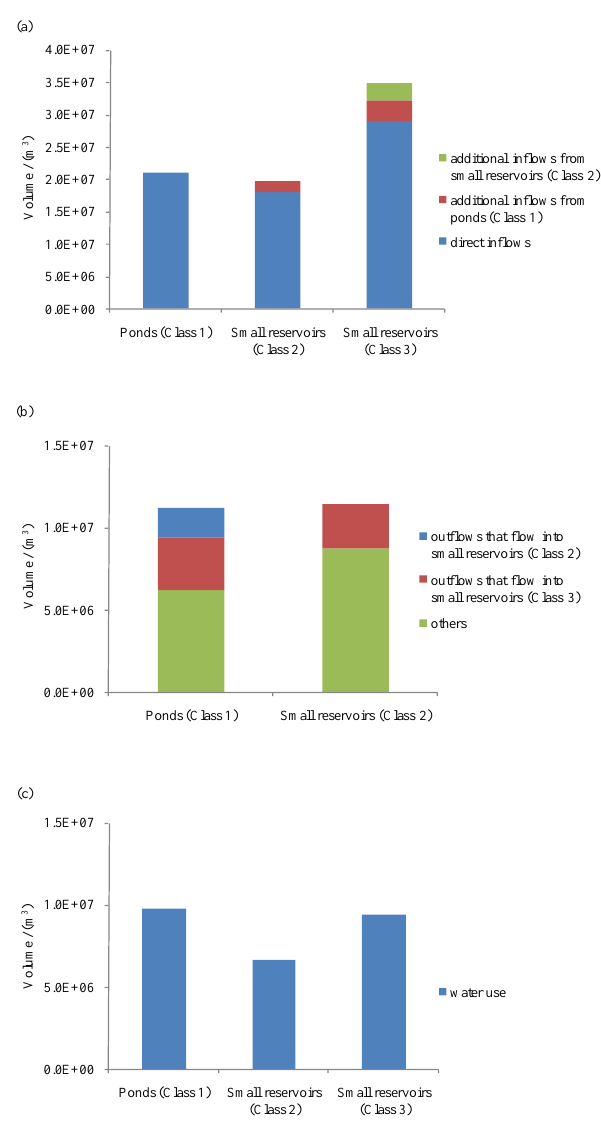
Fig. 10. Water balance and transport through a network combining both sequential and parallel streams and storage links above Panshi hydrologic station over the validation periods: (a) Inflow, (b) Outflow and (c) Water Use.